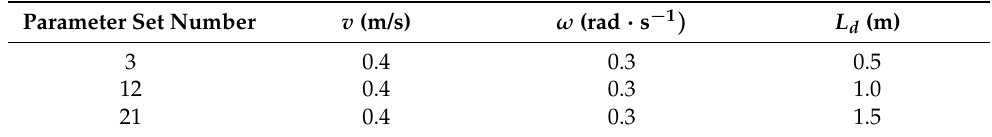
Figure 3. Energy used to complete the path for the specified parameter set number—track 1. Table 2. Variants of parameters (linear velocity, angular velocity, look ahead distance) for which the first path has not been